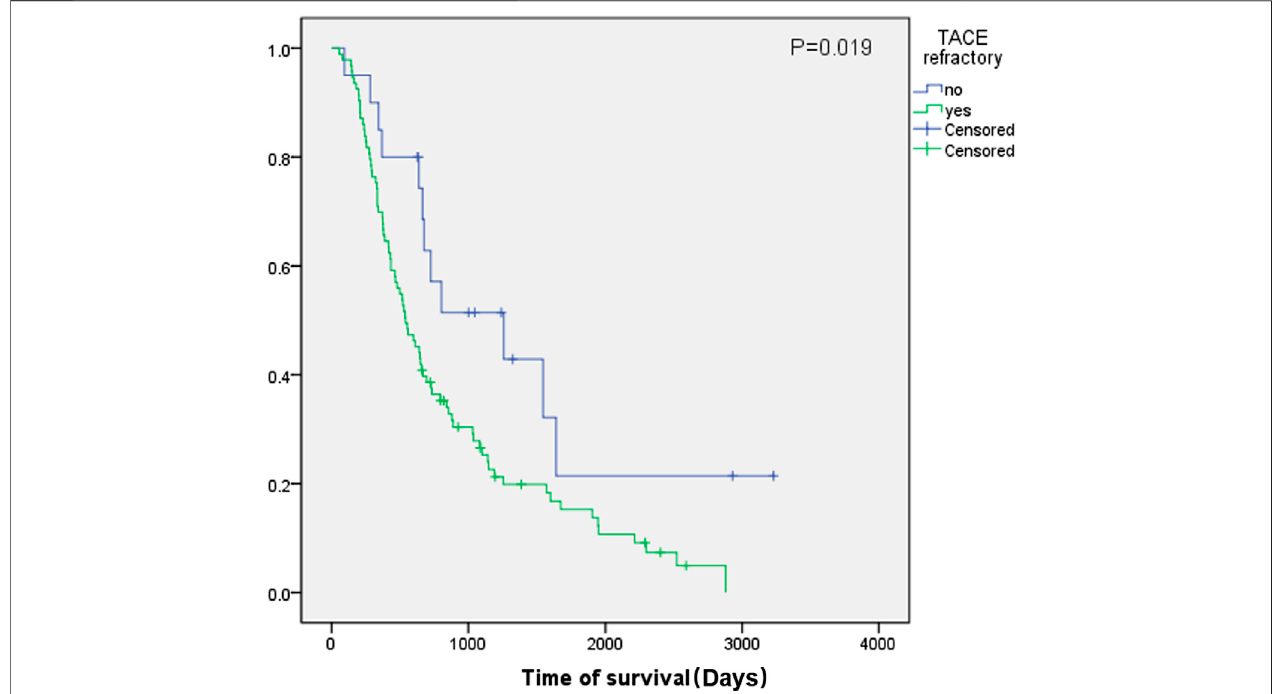
FIGURE 2 | Kaplan-Meier survival curves of the study cohort. Green line: TACE-refractory group. Blue line: TACE-non-refractory group.